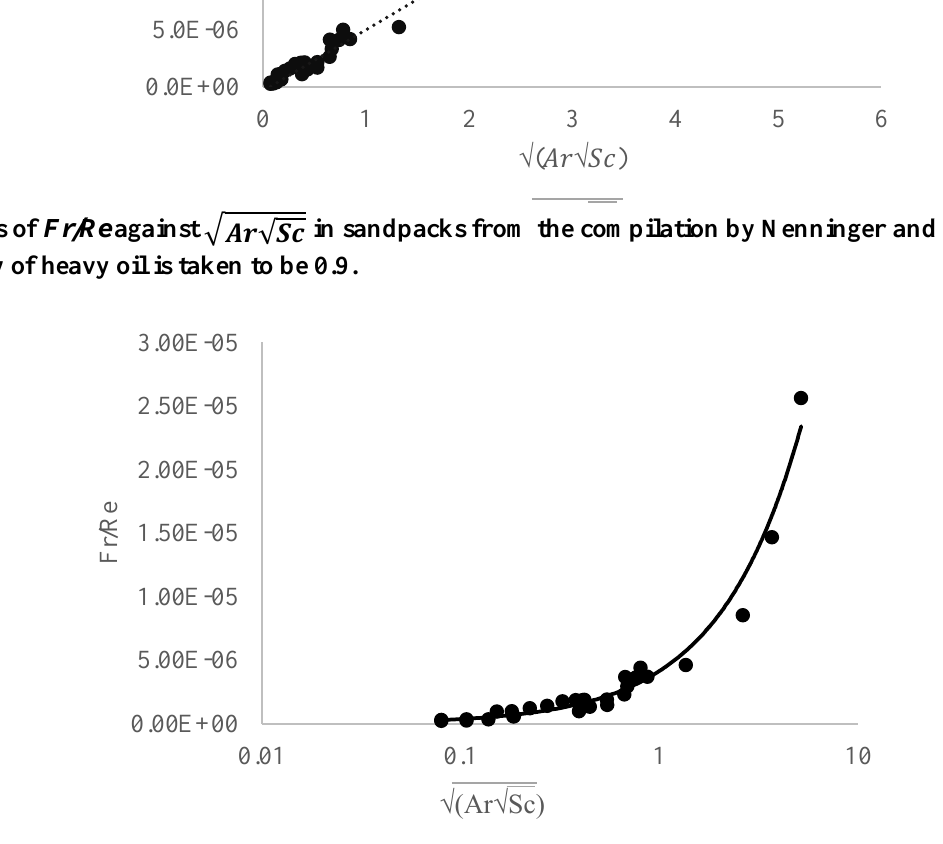
Figure 3—Plots of Fr/Re against √𝑨𝒓√𝑺𝒄 in logscale. Same as in Figure 2 to show the fit at small values of